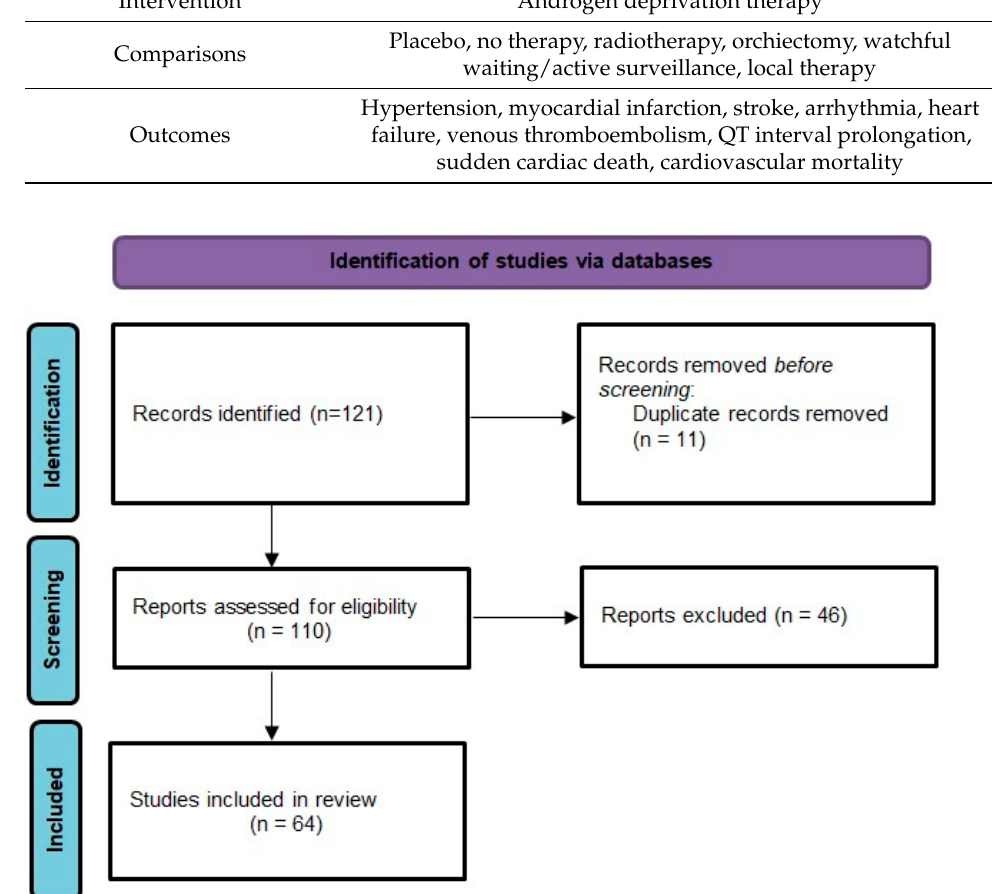
Figure 2. PRISMA 2020 flow diagram for the current review.